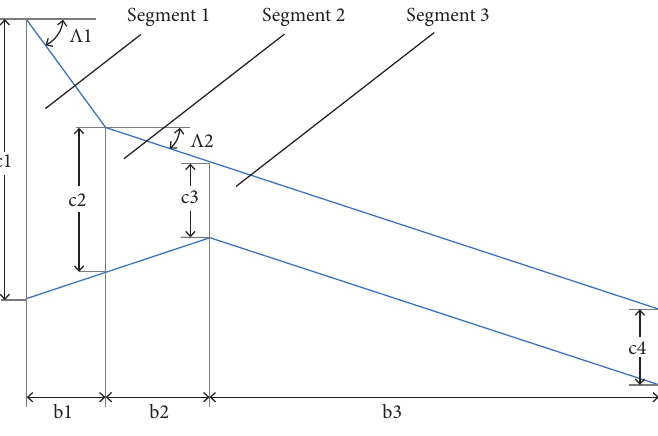
Figure 2. Half of flying wing aircraft